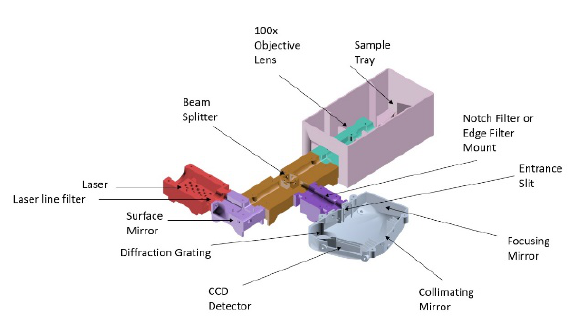
Fig. 3: Top view illustration of the Raman spectrometer system